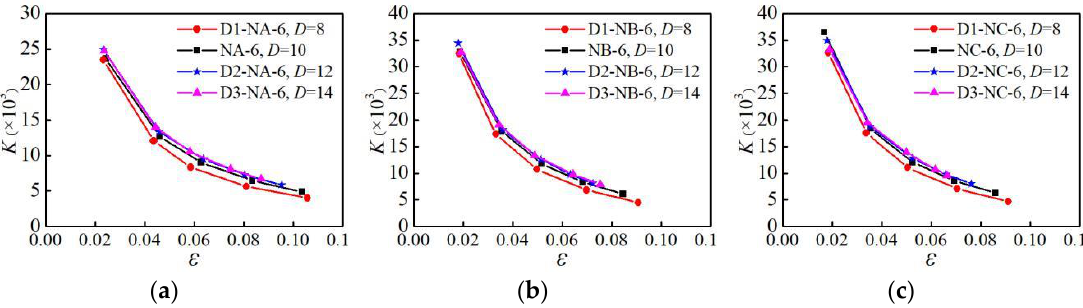
Figure 21. Influence of parallel section diameter on secant stiffness: ( a ) group A of specimens; ( b ) group B of specimens; ( c ) group C of specimens.